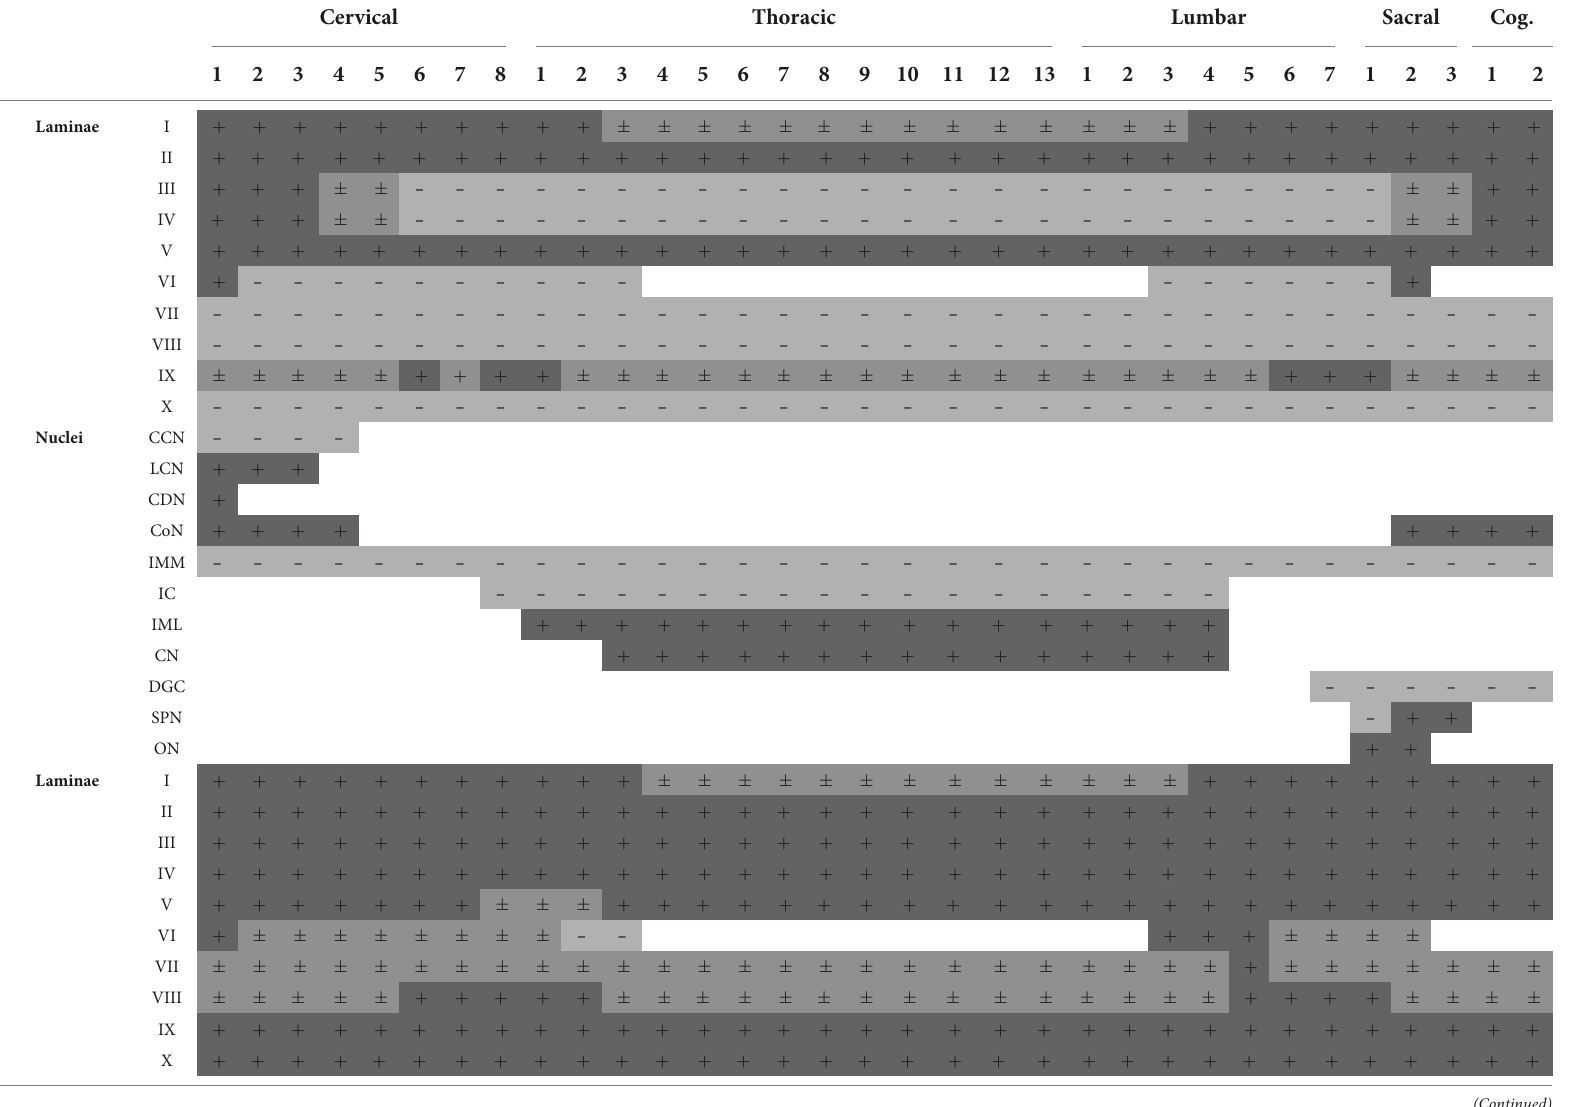
TABLE 4 Markers of the spinal cord laminae and nuclei in all segments.